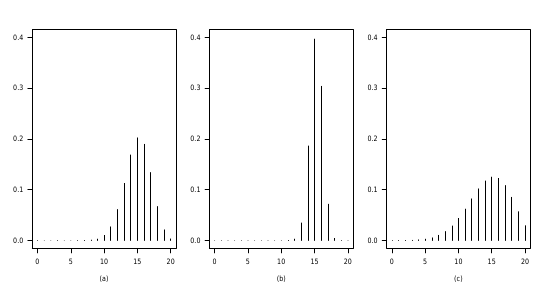
( θ ) } , in panel (a), where m = 20 and θ = 0.75, i ( θ , α ) } , for m = 20, θ = 0.75, and α = 4.15, in panel i